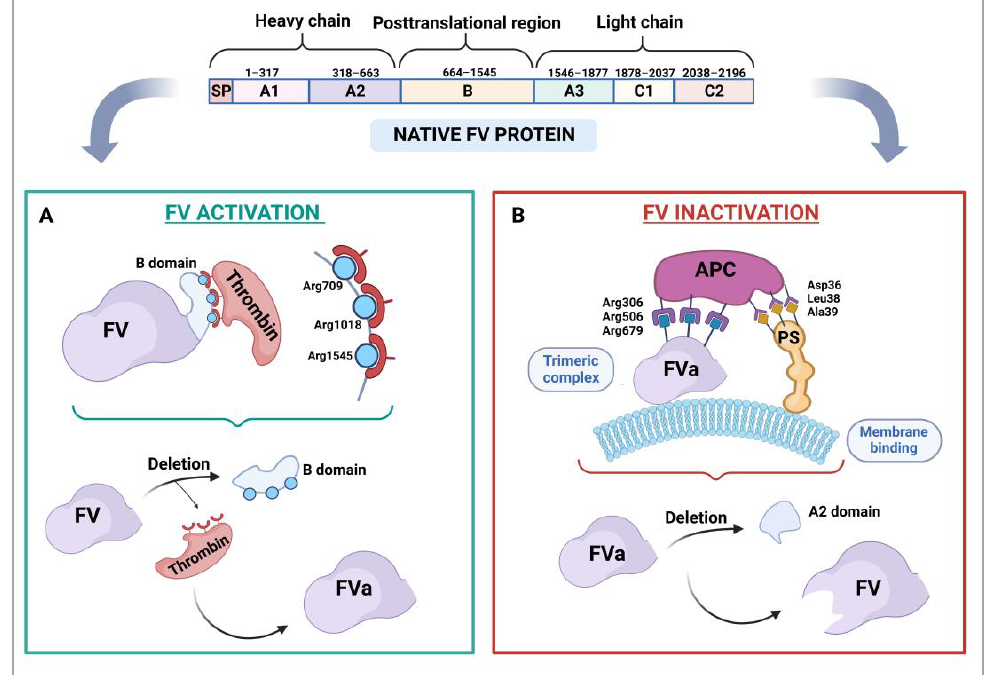
Figure 1. Activation and inactivation of coagulation factor V. The structure of the protein is made up of several domains: A1, A2, B, A3, C1, and C2. ( A ) Thrombin-mediated activation and deletion of the B domain. ( B ) Inactivation by APC and PS, assisted by vascular or platelet membrane phospholipids, and deletion of the A2 domain. FVa: activated factor V; APC, activated protein C; PS, protein S.